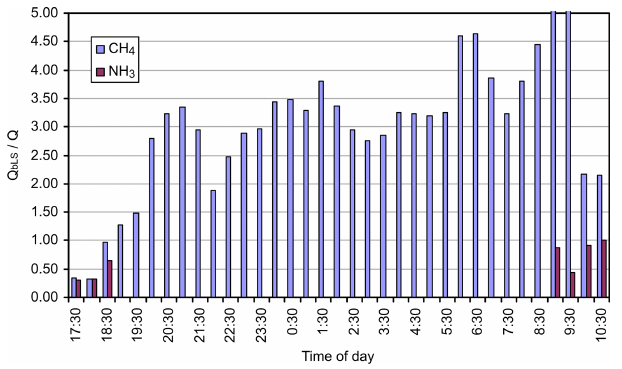
Figure A3. Ratio of calculated ( Q bLS ) to known CH 4 and NH 3 ( Q ) fluxes for the ground-level 40 × 25m grid source (source 4), using OP-FTIR mole fractions and measurement path 2.